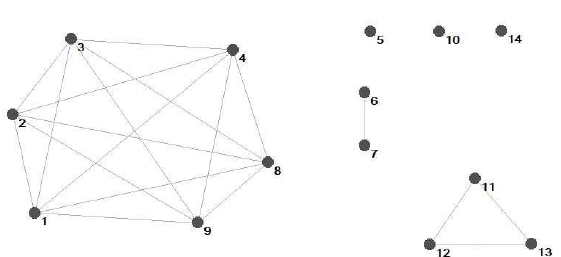
Fig.3. Marc's network in 1995